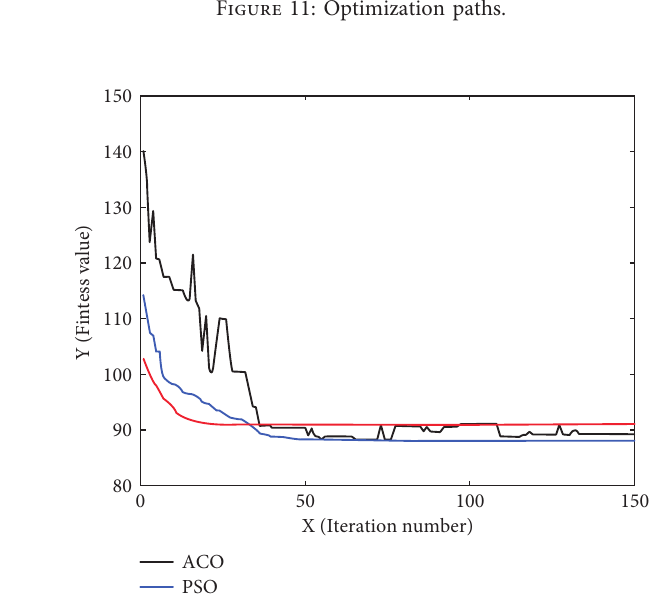
Figure 11: Optimization paths.